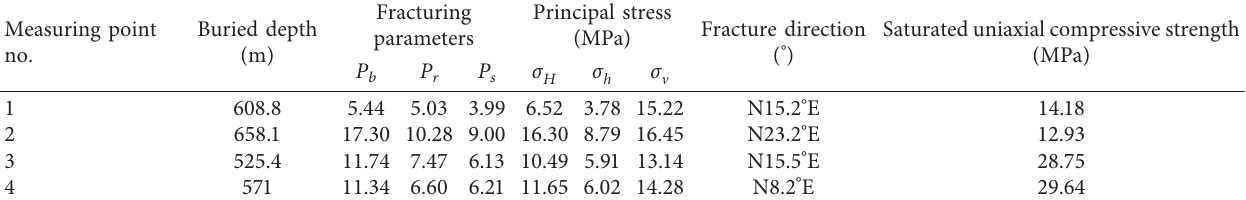
Table 1: In situ stress measurement results of hydraulic fracturing in Zaoquan coal mine. Measuring